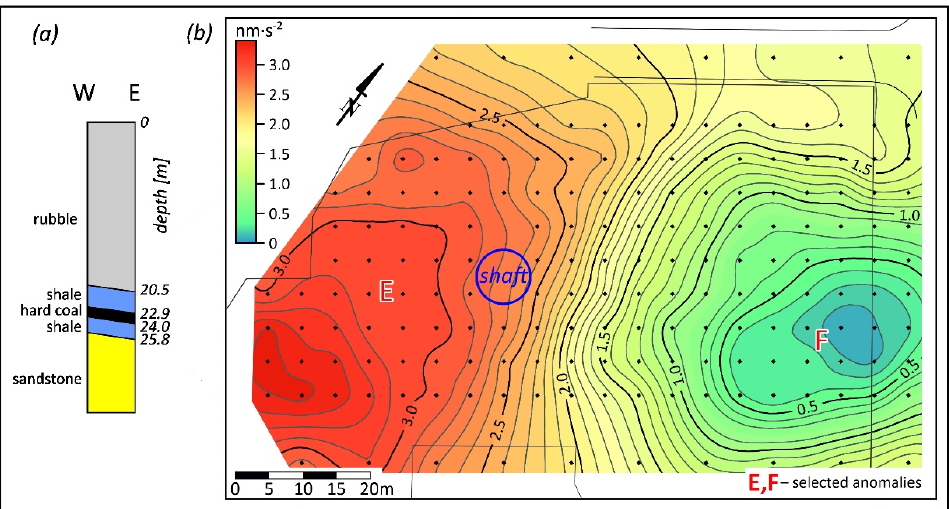
Figure 12. The results of survey: ( a ) main shaft lithology and ( b ) distribution of Bouguer anomalies. Microgravity measurements were performed around the shaft in the area of 95 ×